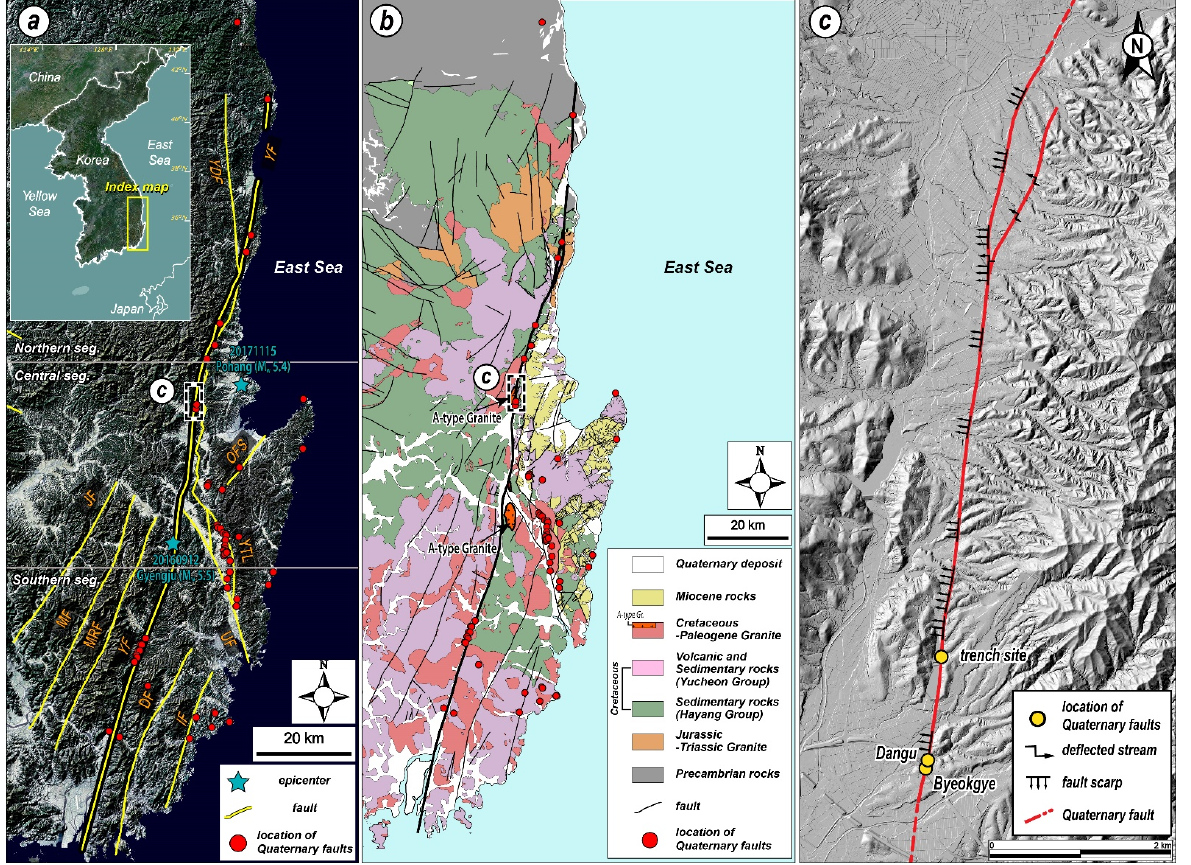
Figure 2. Regional and detailed study area maps. ( a ) Topographic Landsat TM satellite image map of SE Korea. Major fault locations: Yangsan fault (YF), Yeongdeok fault (YDF), Jain fault (JF), Miryang fault (MF), Moryang fault (MF), Dongnae fault (DF), Ilgwang fault (IF), Ocheon fault system (OFS), Yeonil tectonic line (YTL), Ulsan fault (UF), Quaternary faults (QFs), and recent epicenters (modified from [38,63,73]). The YF consisting of three segments (left side/white). ( b ) Regional geological map of SE Korea (modified from [74,76,77,80–84]). The bold line representing the YF indicates a dextral offset of approximately 21 km and is aligned with the A-type granite in the study area. ( c ) Detailed high resolution light detection and ranging (LiDAR) image hillshade fault trace map.